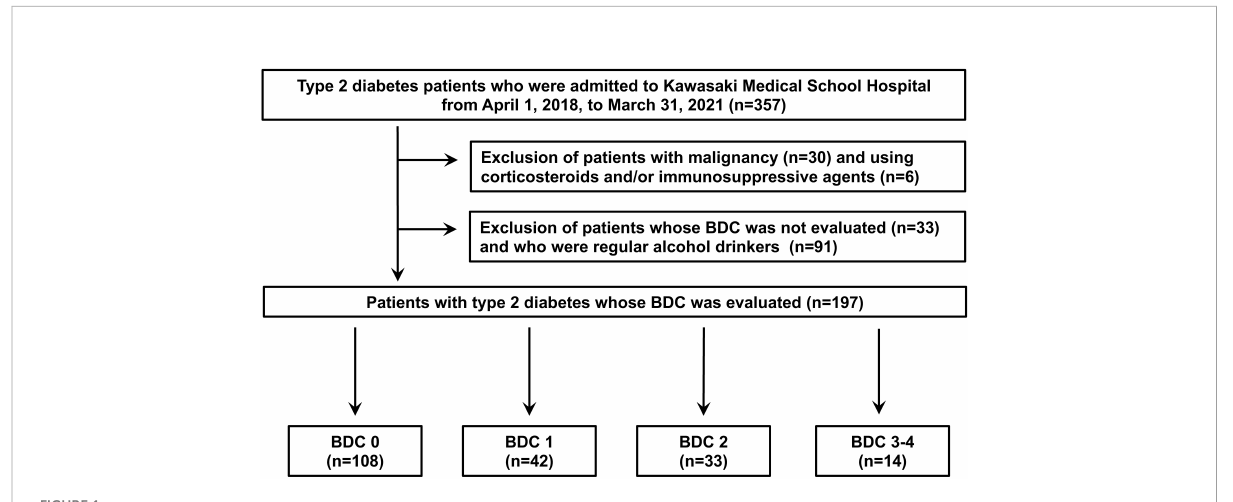
FIGURE 1 The fl owchart of the participants and exclusions in this